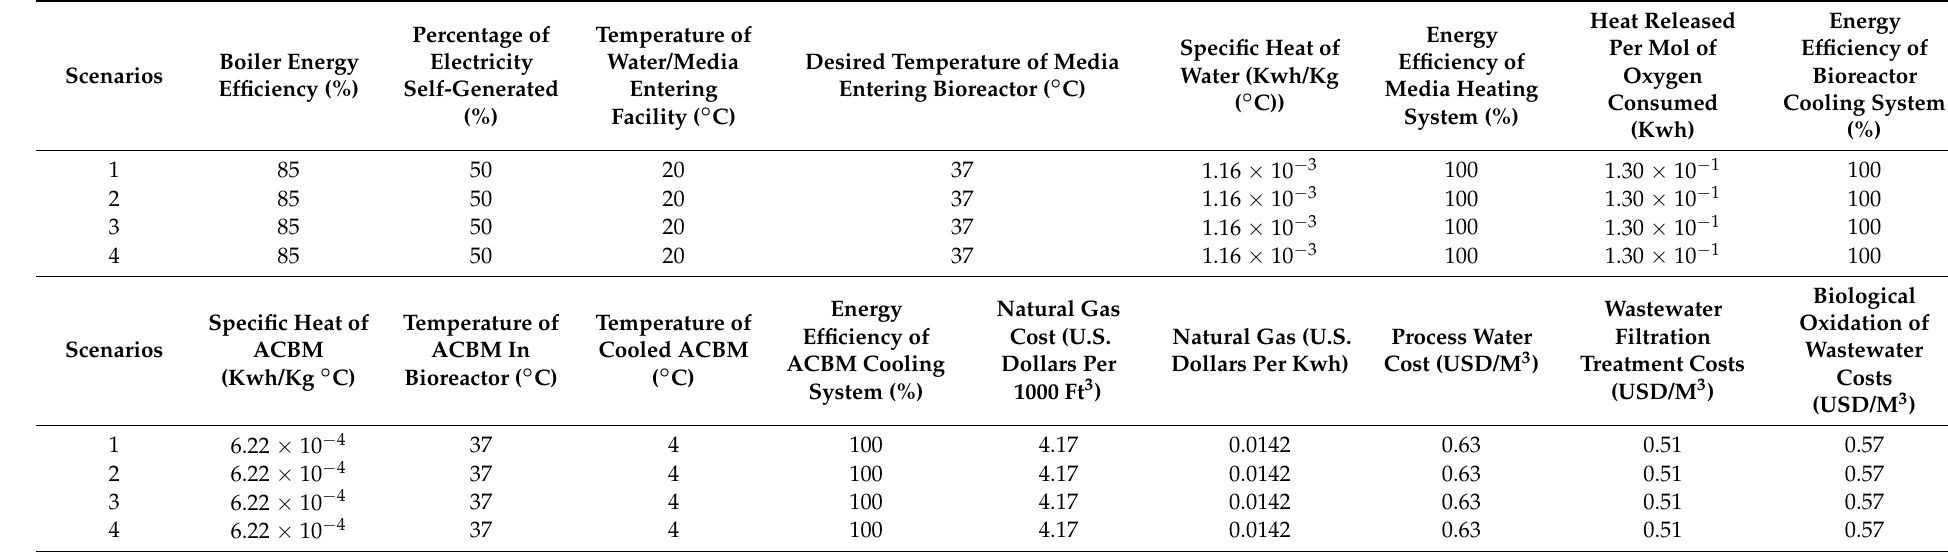
Table A5. Model variable inputs: